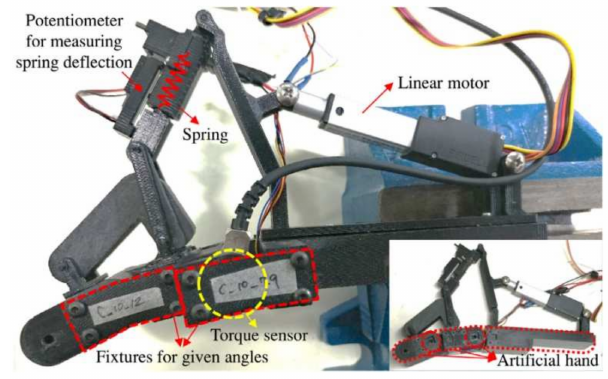
Figure 3. A portable and spring-guided hand exoskeleton [25].